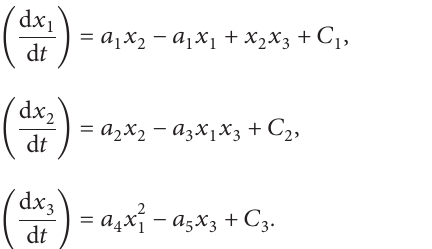
� 10. (c) Fixed point solution in ( x 1